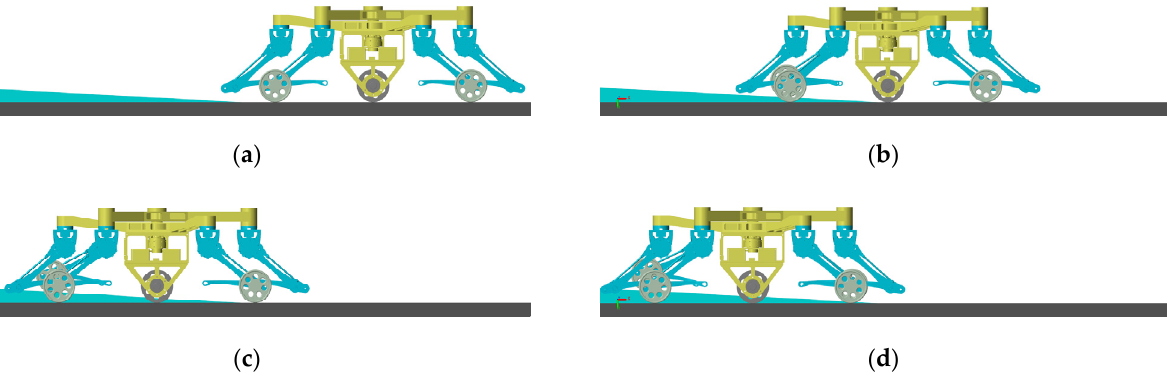
Figure 15. Vertical contact force between wheels and ground (all wheels on slope). ( a ) active wheel; ( b ) passive wheels.